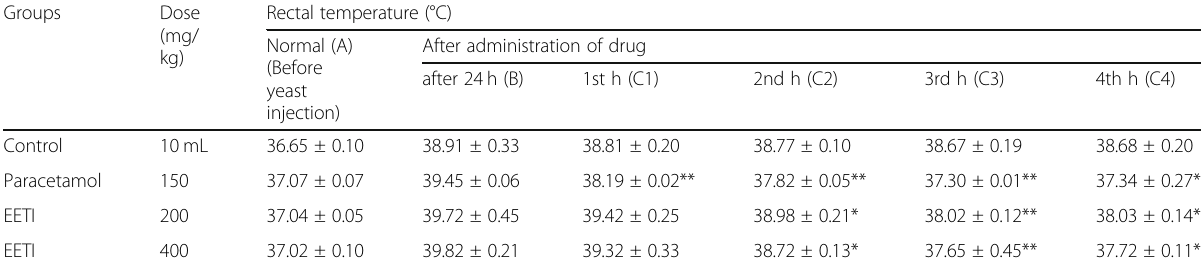
Table 5 Effect of EETI on Yeast-induced pyrexia in mice Groups